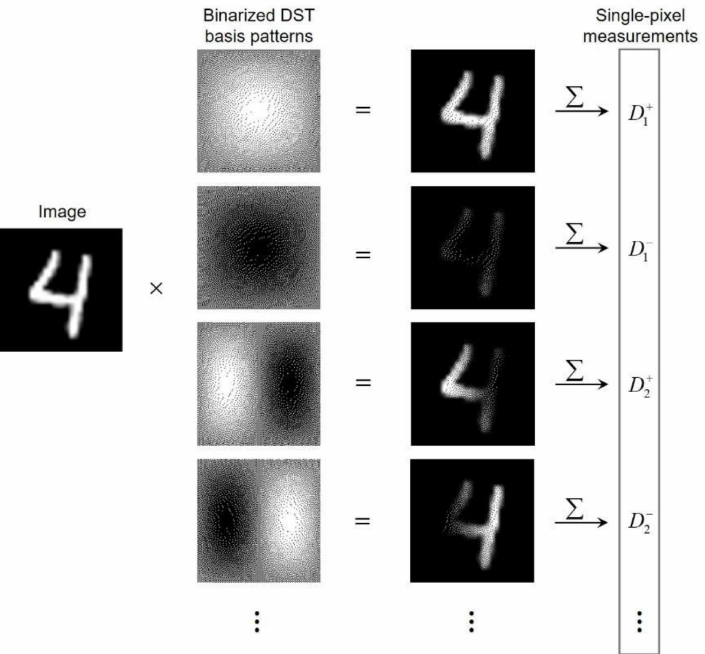
Figure 6. Process of generating simulation data of single-pixel